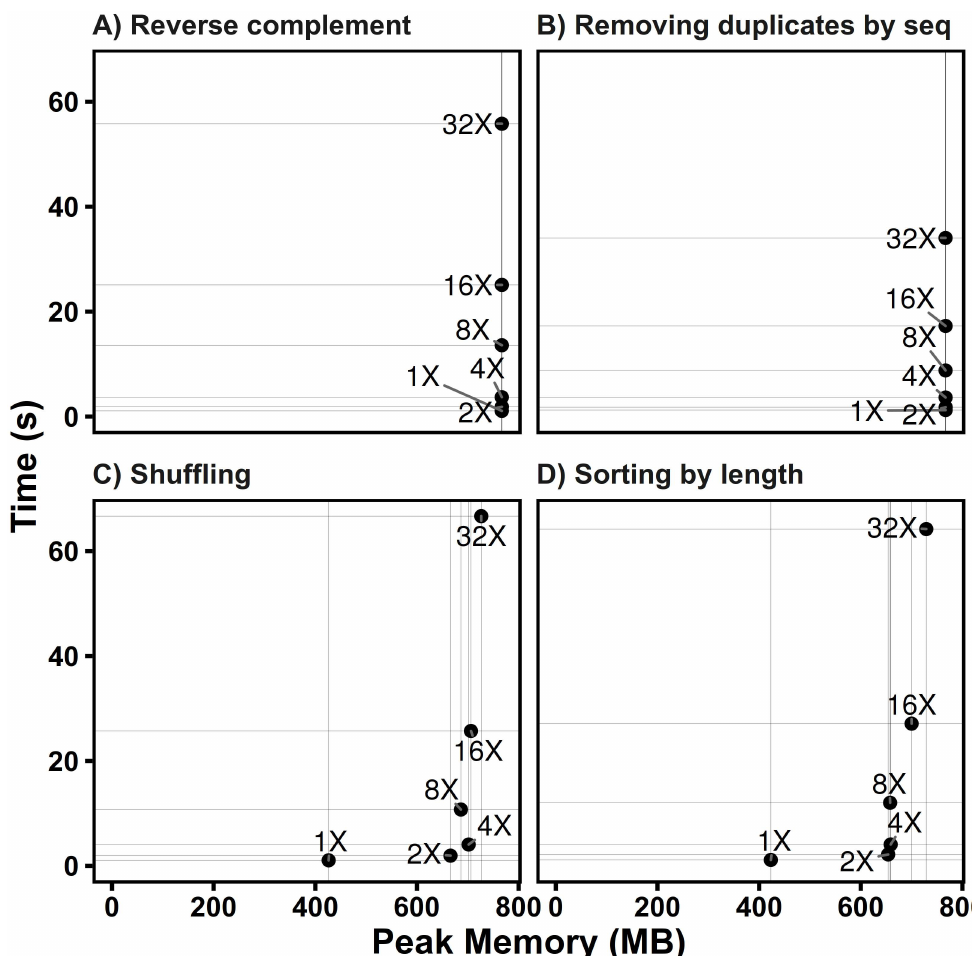
Fig 3. Performance of SeqKit on different data sizes. The text label represents file size relative to the human genome chromosome 1 (248,956,422 bp, file size: 241.4 Mb). All tests were repeated three times, and the average time or memory usage was computed. See supplementary data for details of test data and